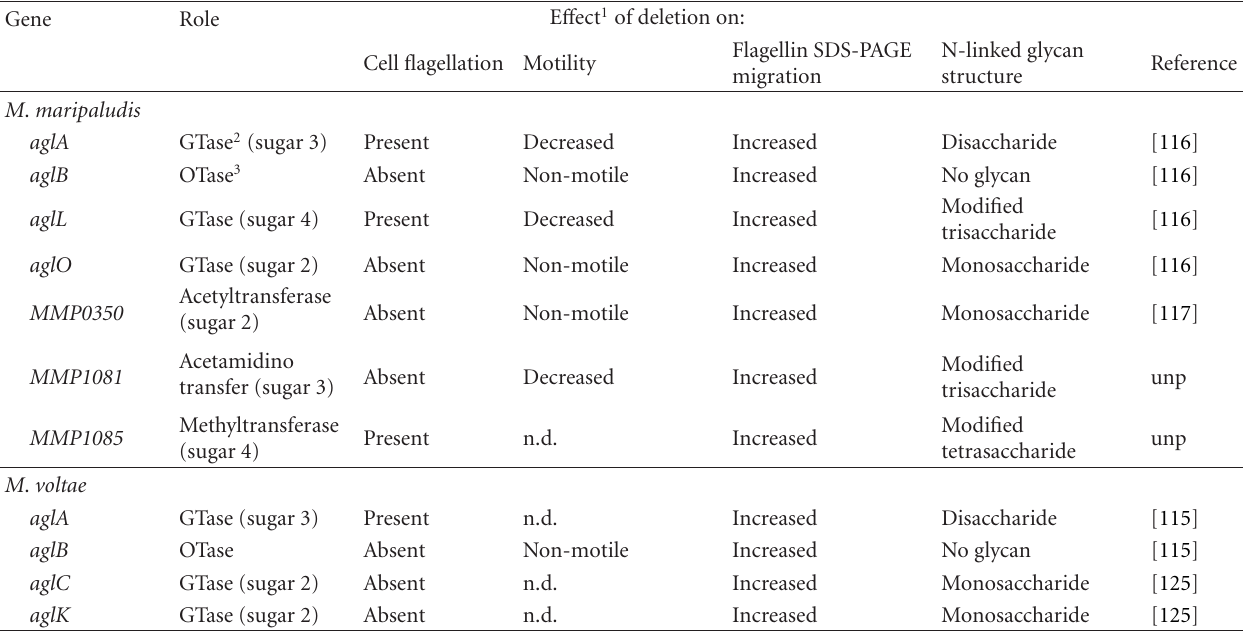
Table 2: E ff ects of M . maripaludis and M . voltae agl